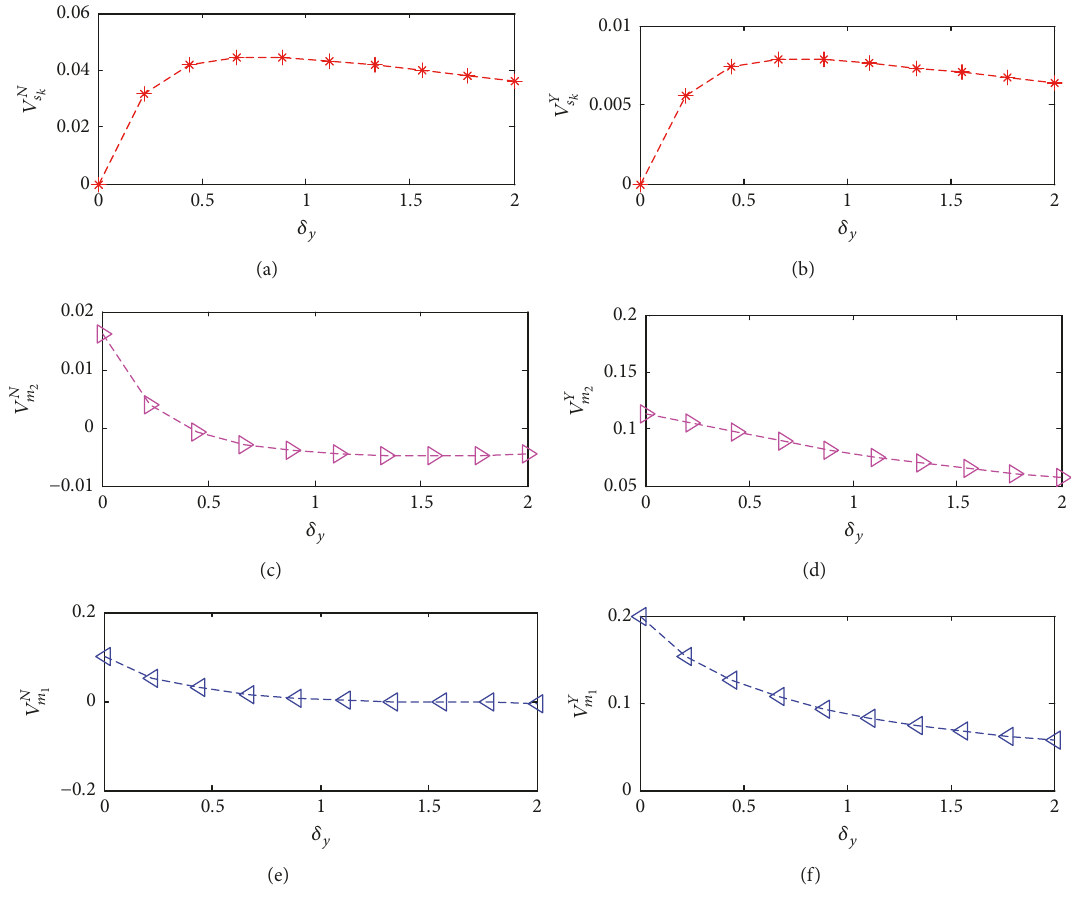
Figure 2: The impact of 𝛿 𝑦 on 𝑉 𝑁 𝑠